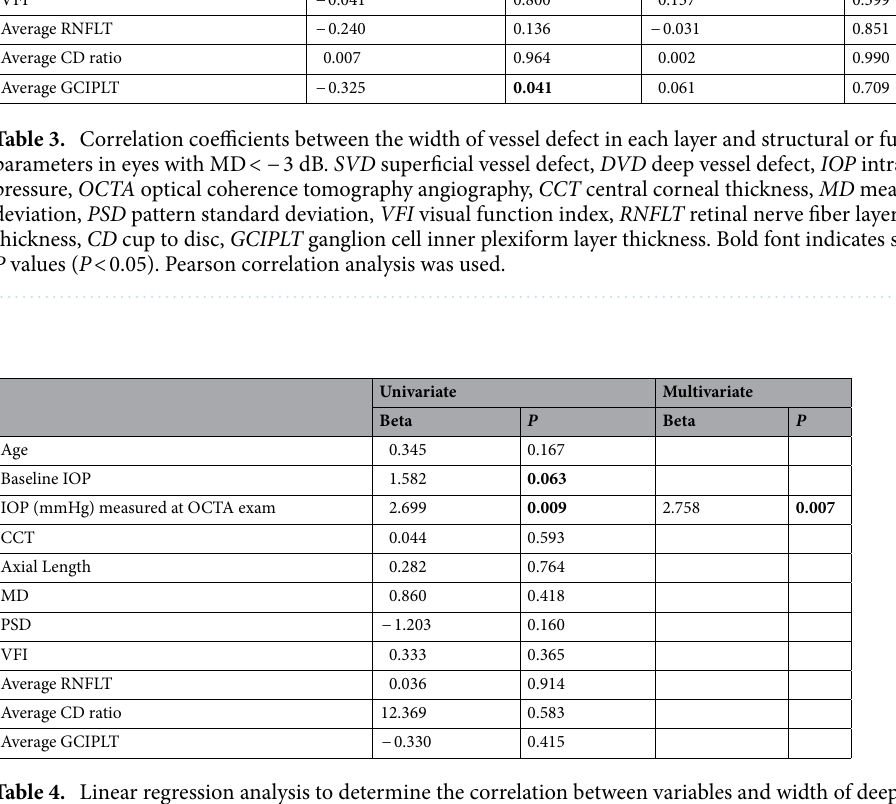
Table 4. Linear regression analysis to determine the correlation between variables and width of deep vascular defect in all eyes (N, 72). SVD superficial vessel defect, DVD deep vessel defect, IOP intraocular pressure, OCTA optical coherence tomography angiography, CCT central corneal thickness, MD mean deviation, PSD pattern standard deviation, VFI visual function index, RNFLT retinal nerve fiber layer thickness, CD cup to disc, GCIPLT ganglion cell inner plexiform layer thickness. Only variables with a P value < 0.10 in the univariate analysis were included in the multivariate model. Bold font indicates significant P values ( P <